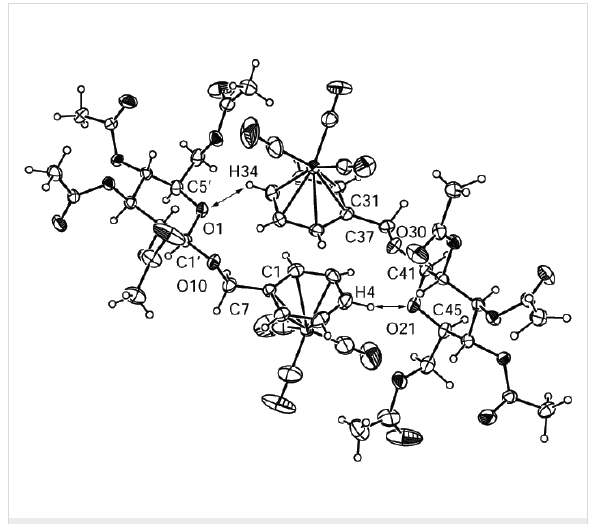
Figure 2: ORTEP-plot of the asymmetric unit containing two mole- cules of compound 2a showing 30% probability ellipsoids; the arrows show the nonclassical H-bonds between O1 and H34 and O21 and